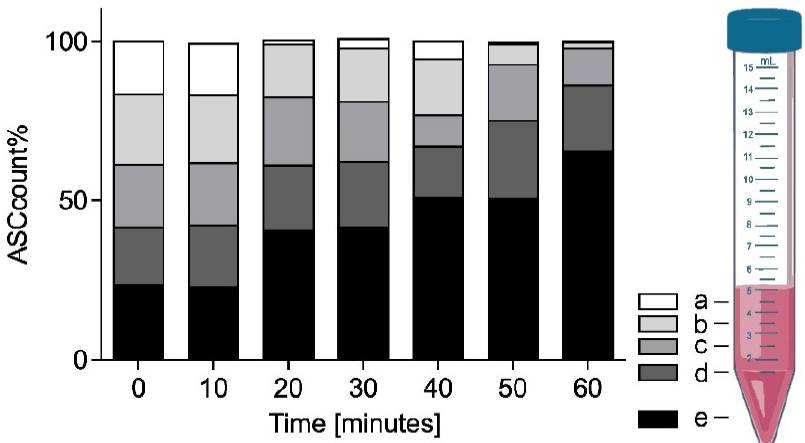
Figure 8. Fractional ASC count over 60 min showing increasing sedimentation within a 5 mL sample. Locations (a–e) correspond to 1-mL increment fill